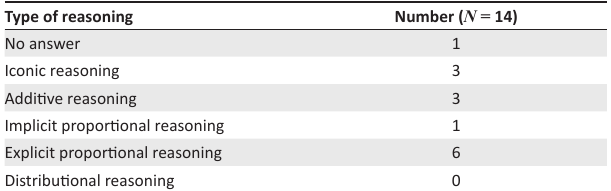
TABLE 2: Summary of responses to Question 1: Reasons for expected number of